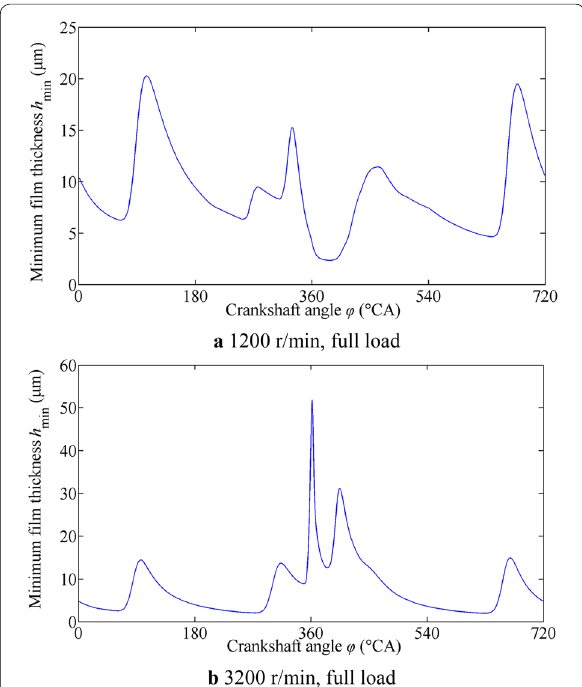
Figure 9 Minimum oil film thickness of connecting-rod bearing